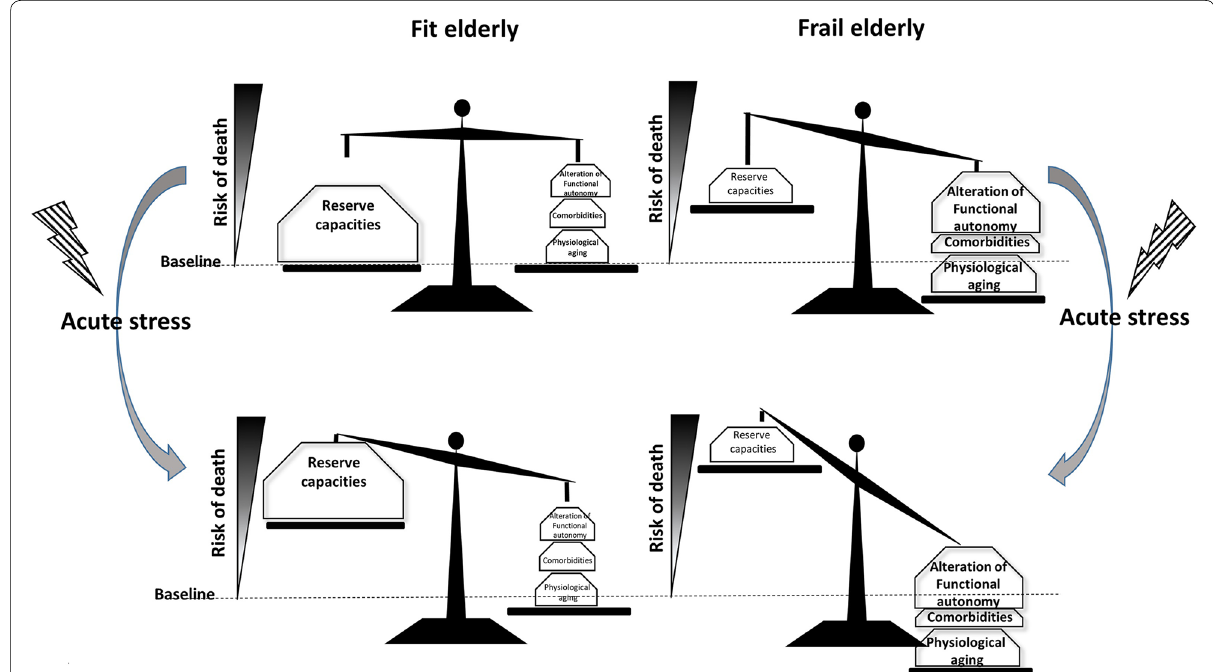
Fig. 2 Impact of acute stress on fit or frail elderly. Physiological aging, comorbidities and functional dependency are the main components of frailty syndrome, leading to decrease in reserve capacities. At baseline, impact of frailty on survival is slight but its weight dramatically grows in case of acute stress (all medical events leading to ICU admission) and increase the risk of death comparatively to the fit